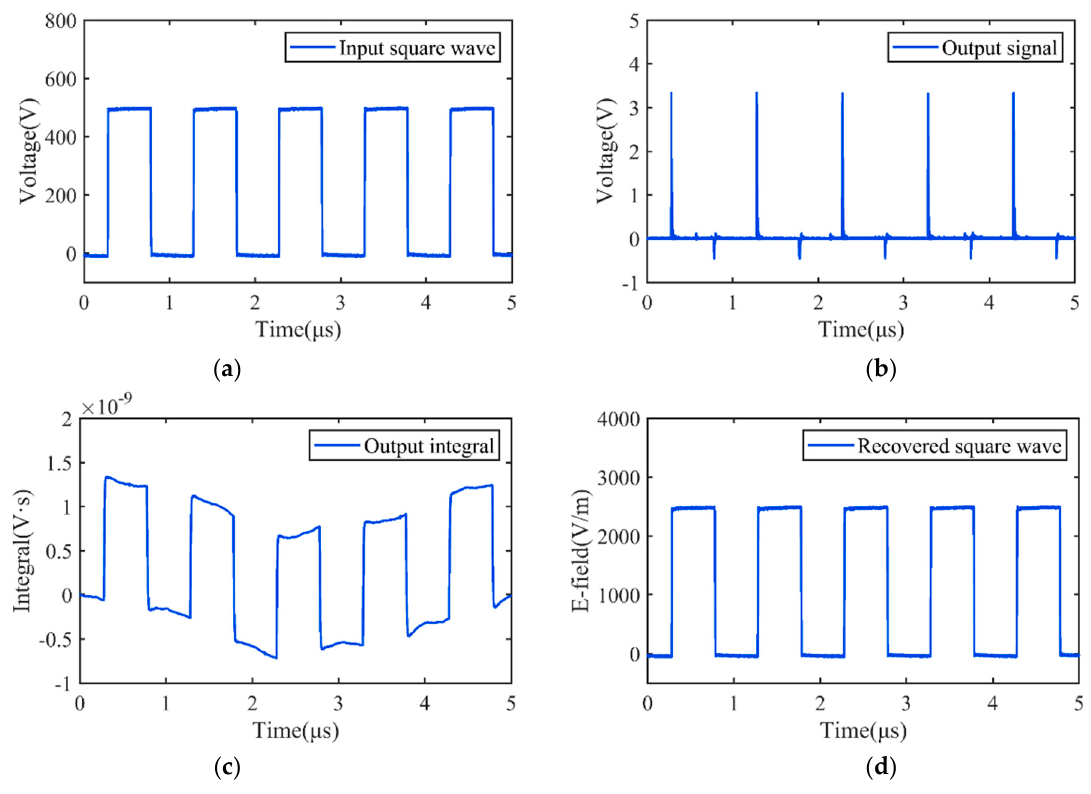
Figure 12. Pulse reconstruction by Hammerstein system compensation.